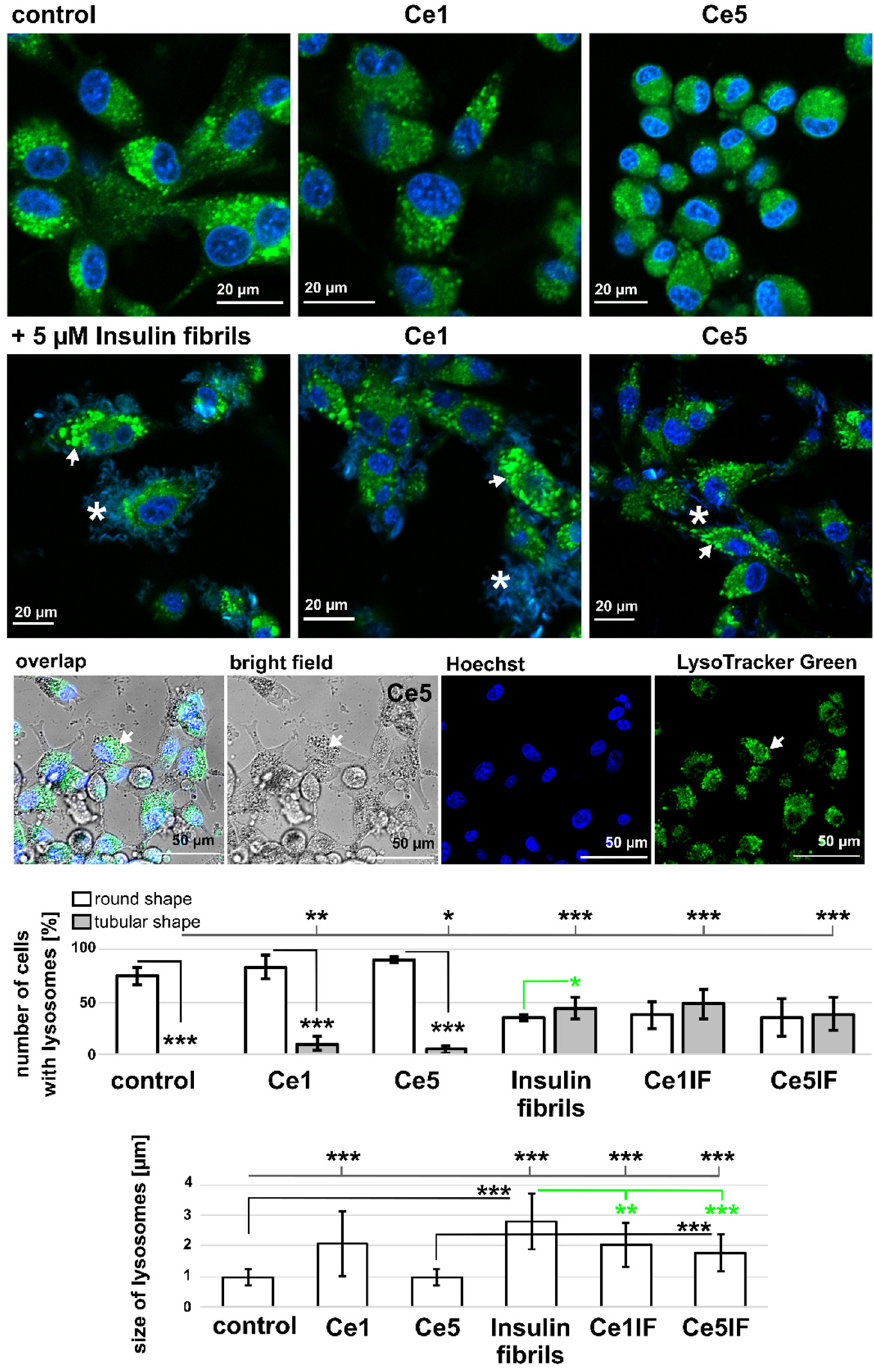
Figure 7. Representative fluorescent images of U87 MG cells labeled with LysoTracker Green (green, lysosomes) and Hoechst (blue, nuclei). The cells were subjected for 24 h to Ce1 and Ce5 nanoparticles at a concentration of 150 µ g/mL and to 5 µ M insulin fibrils (IF). Tubular-shaped lysosomes in the presence of insulin fibrils are denoted with white arrows (2nd row). Insulin fibrils adsorbed to the cell surface can be observed as blue fibers (white asterisks). A representative overlap image of a bright-field image with the fluorescence of Hoechst (blue)- and LysoTracker Green (green)-labeled cells in the presence of Ce5 NPs (3rd row). Co-localization of lysosomes and Ce5-NP-loaded vesicles is denoted with a white arrow. The numbers of cells with round (white columns) and tubular (grey columns) lysosomes were evaluated (400 cells for each studied case). The size of the lysosome was measured as the diameter of the lysosome. The level of significance was estimated with a one-way ANOVA test: * p < 0.05, ** p < 0.01, *** p <